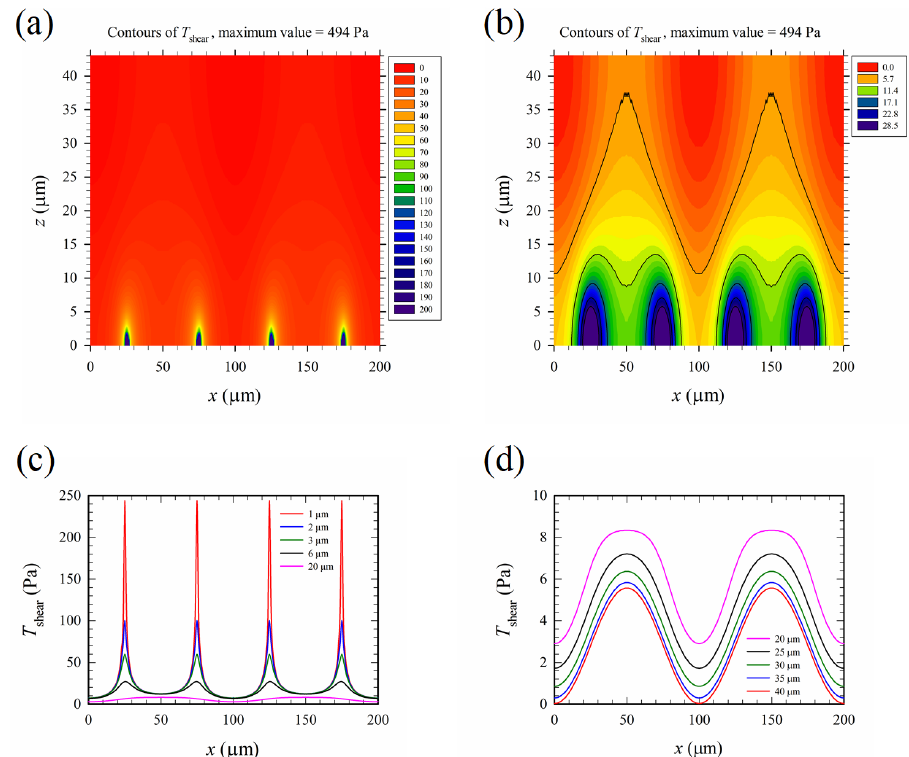
Figure 7. ( a ) Contours of the maximum Maxwell shear stress, T shear (full range). ( b ) Contours of T shear (partial range) for a clear picture of values around 5.7 Pa, which corresponds to E rms = E th2 = 1.2 × 10 5 in Figure 6d. The black curves starting from above in ( b ) are the major contours of values 5.7, 11.4, 17.1, 22.8, and 28.5 Pa, respectively (similar convention as that in Figure 6). There are five minor contours between any two major contours, with a 0.95 Pa di ff erence in values between any two minor contours. ( c ) and ( d ) Variations of T shear with x at different heights ( z ). The applied voltage is 20 V pp .